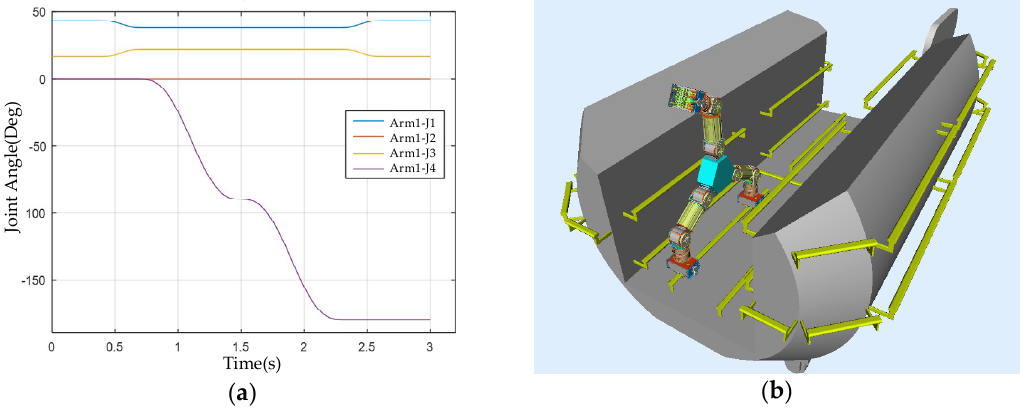
Figure 11. The simulation of the robot’s motion. ( a ) The motion planning data; ( b ) Display interface of robot motion simulation system.